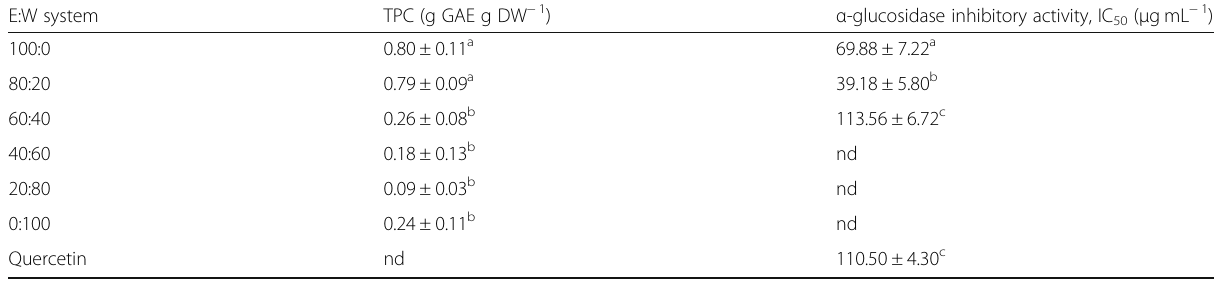
Different letters in the column indicate significant differences ( p <0.05) using Duncan ’ s test. Values are expressed as the mean±standard deviation ( n =3). nd not